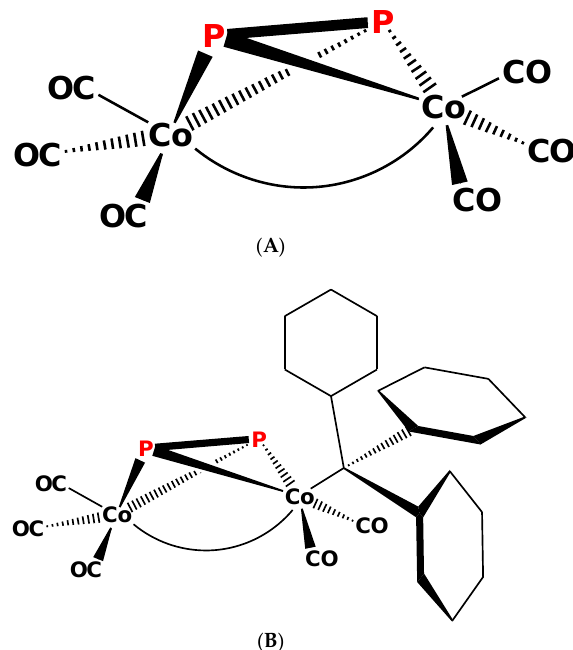
Figure 1. Schematic view of the structure ( A ) of complex 1 [1,2]; Schematic view of the structure ( B ) of complex 3 [3].